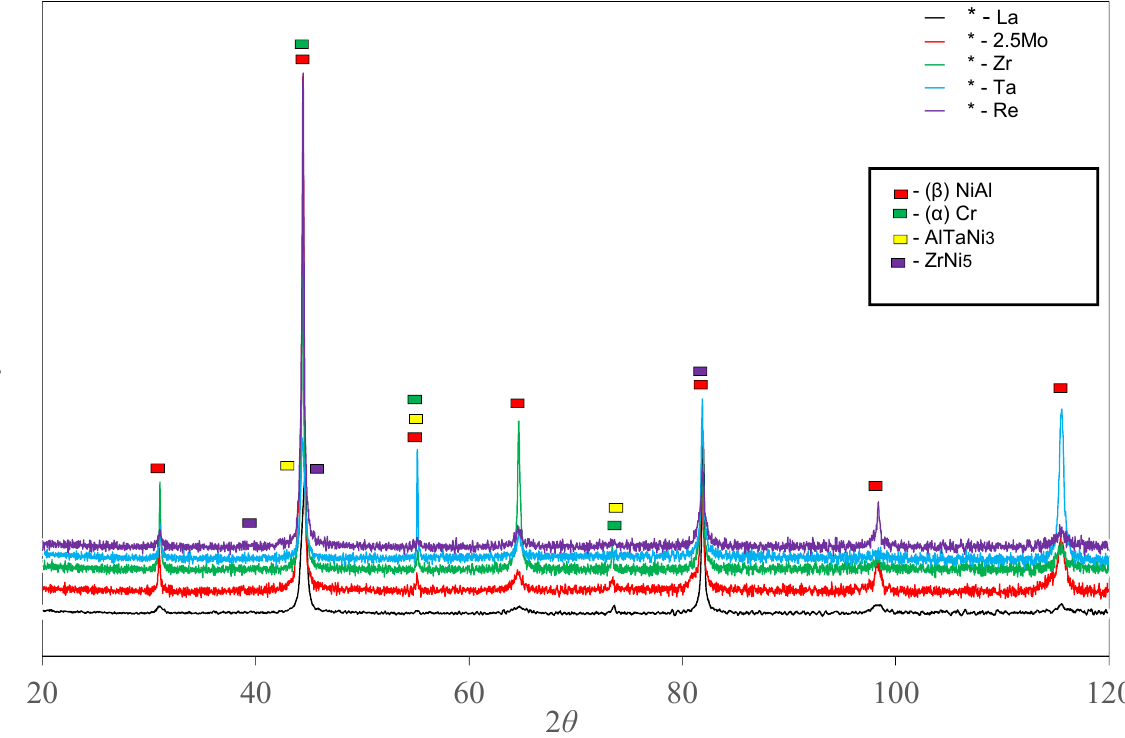
Materials 2021 , 14 , x FOR PEER REVIEW Figure 3. The X-ray diffraction (XRD) patterns of the NiAl–Cr–Co–( X ) alloys, X = La, 2.5%Mo, Zr, Ta, and Re. Table 5. The phase composition and mechanical properties of the cast NiAl–Cr–Co–( X ) alloys and individual phases. Sample Phase Phase Con- Lattice Pa- Alloy Phase tent, % rameter, Å H , GPa E , GPa H , GPa E , GPa